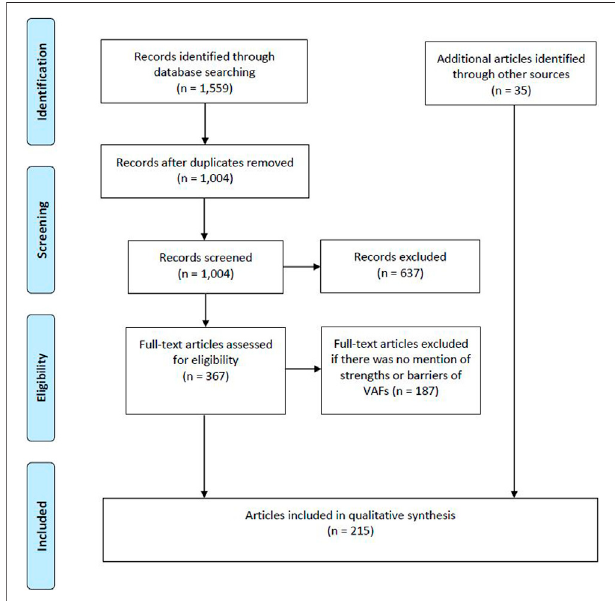
FIGURE 1 | PRISMA fl ow diagram of search strategy